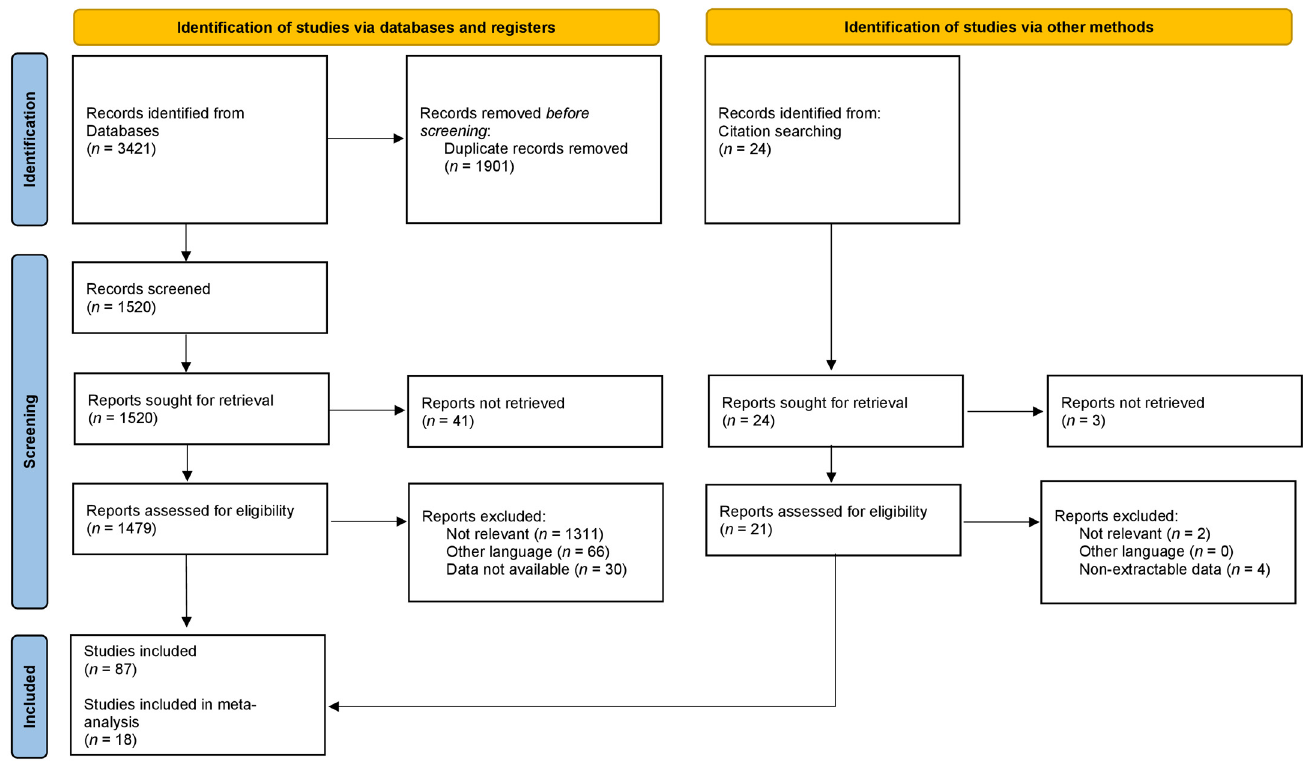
Figure 1. PRISMA 2020 flow diagram and the selection of studies.